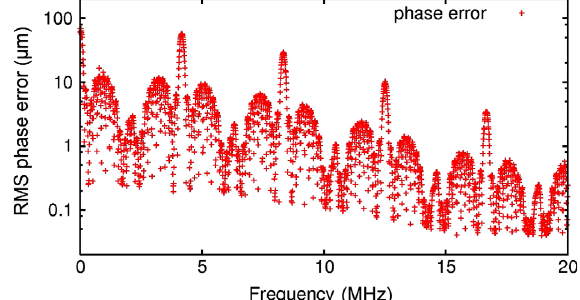
FIG. 15. Phase error caused by 0.1% drive beam bunch charge error jitter vs frequency of the bunch charge jitter, calculated with realistic rf filling and beam loading functions. The maximal phase error value of 170 μ m correspond to 2.5° at 12 GHz.